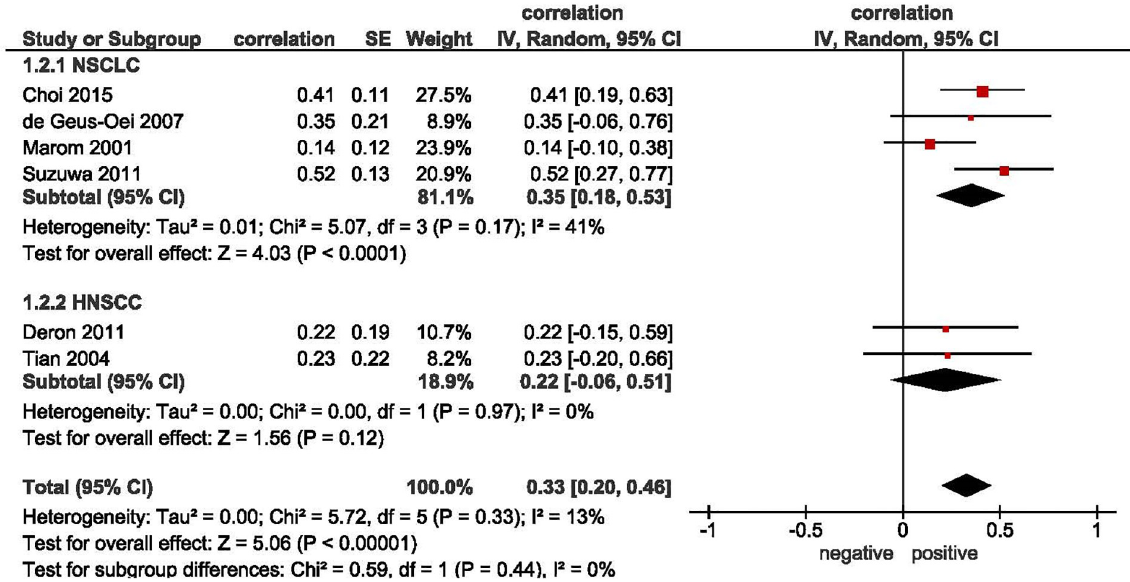
Fig 6. Subgroup analyses for the correlation between SUVmax and GLUT 3 expression. Forrest plots of the correlation coefficients between SUVmax and GLUT 3 in HNSCC and NSCCL subgroups.